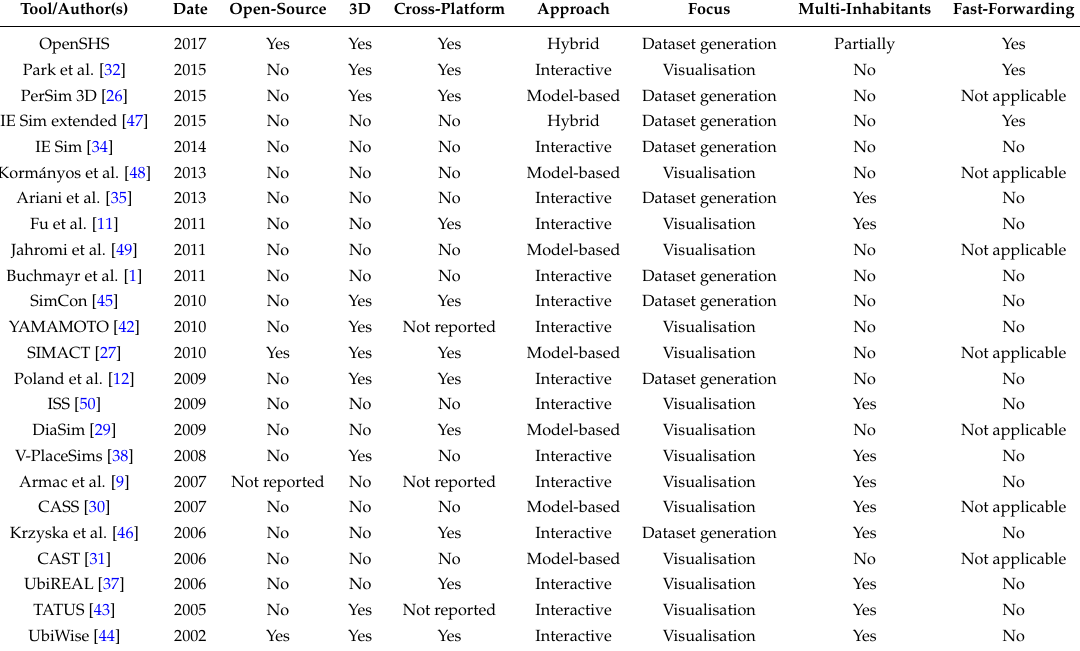
Table 1. Analysis of smart home simulation tools. OpenSHS, open-source, cross-platform 3D smart home